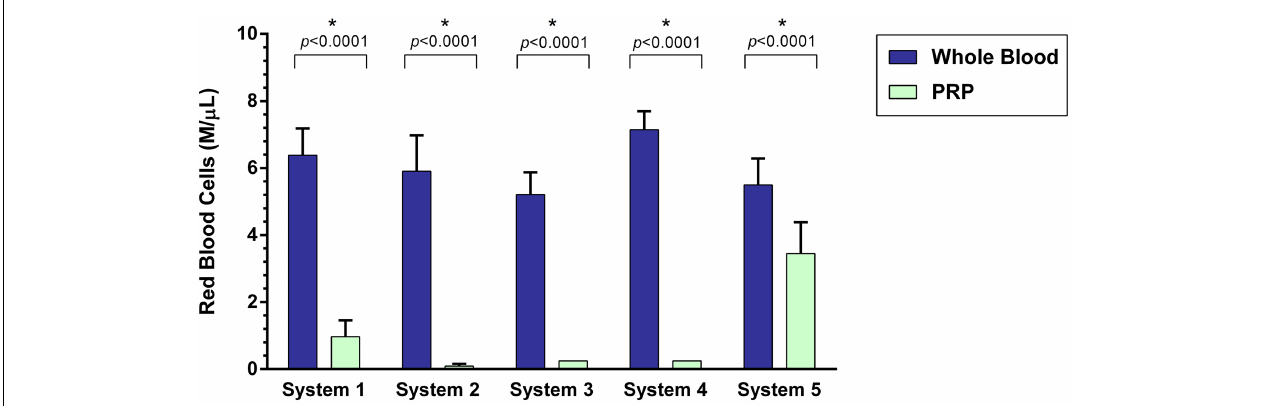
FIGURE 2 | Comparison of mean whole blood and mean PRP product RBC concentrations between five commercial PRP systems . An asterisk (*) indicates a statistically significant difference between the mean whole blood and mean PRP product for that PRP system. Bars represent mean (cid:6) 95% CI ( n = 10).